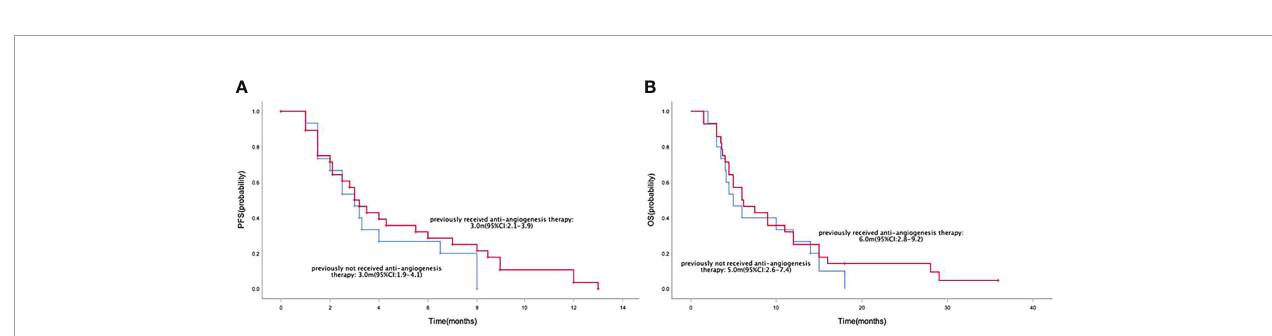
FIGURE 4 | Kaplan-Meier curve of PFS (A) and OS (B) in the patients who had or not previously received anti-angiogenesis therapy